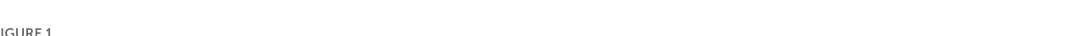
FIGURE1 Exe-Exo (50 µ g/ml) for 48 h, followed by starvation for 6 h and stimulation with VEGF165 (100 ng/ml) for 20 min. Cells proliferation was determined by CCK8 (I). Cell migration was determined by scratch assay, representative images (H) and quantitative analysis (J). Representative images (H) and a quantitative analysis (K) of tube formation. FAL, femoral artery ligation. Sed-Exo, exosome purified from the plasma of sedentary rats. Exe-Exo, exosome purified from the plasma of exercised rats. * P < 0.05, ** P < 0.01, *** P < 0.001. Each experiment was repeated 5 times. Scale bar = 50 or 100 µ m as presented in the above images. Data are means ±